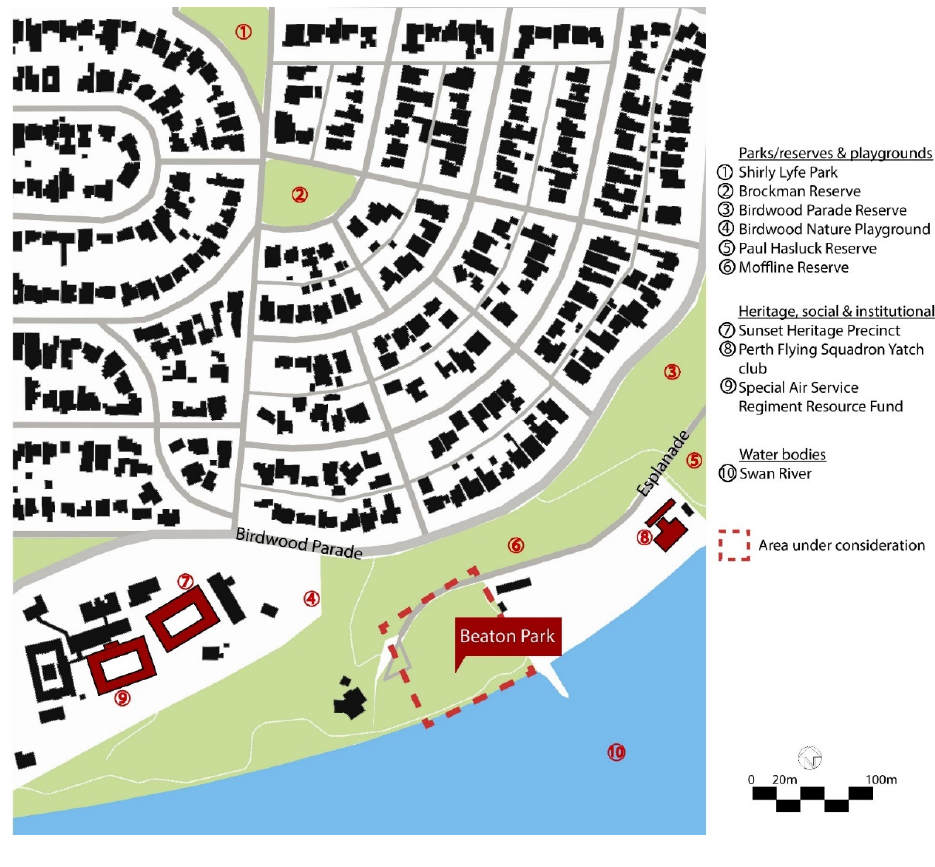
Figure 9. Contextual location.